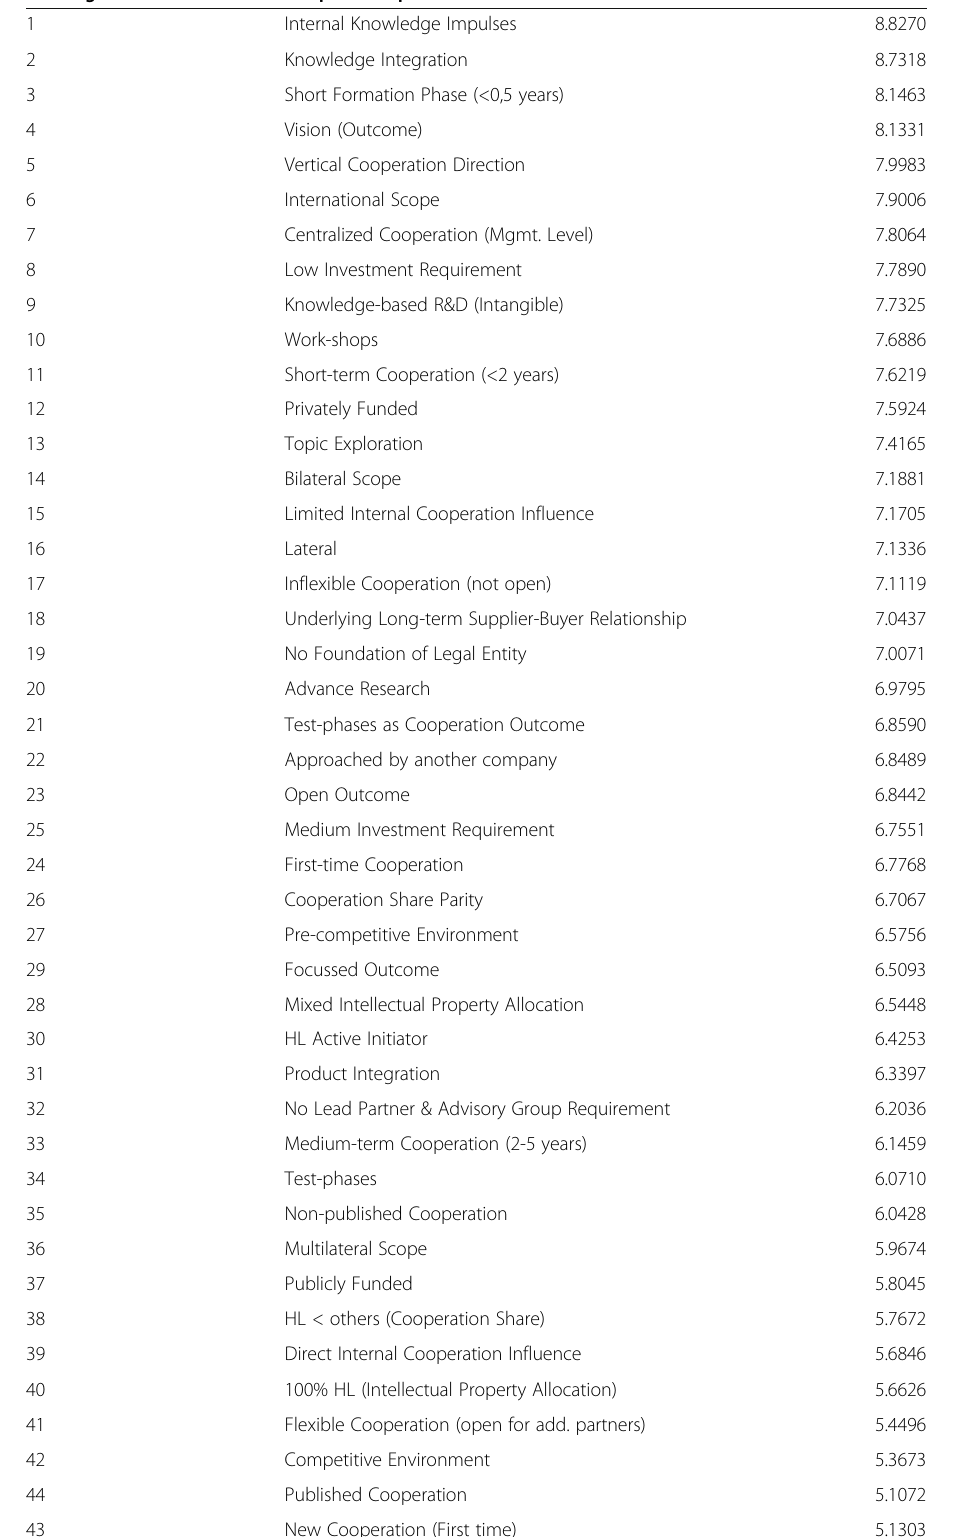
Table 3 Cooperation elements